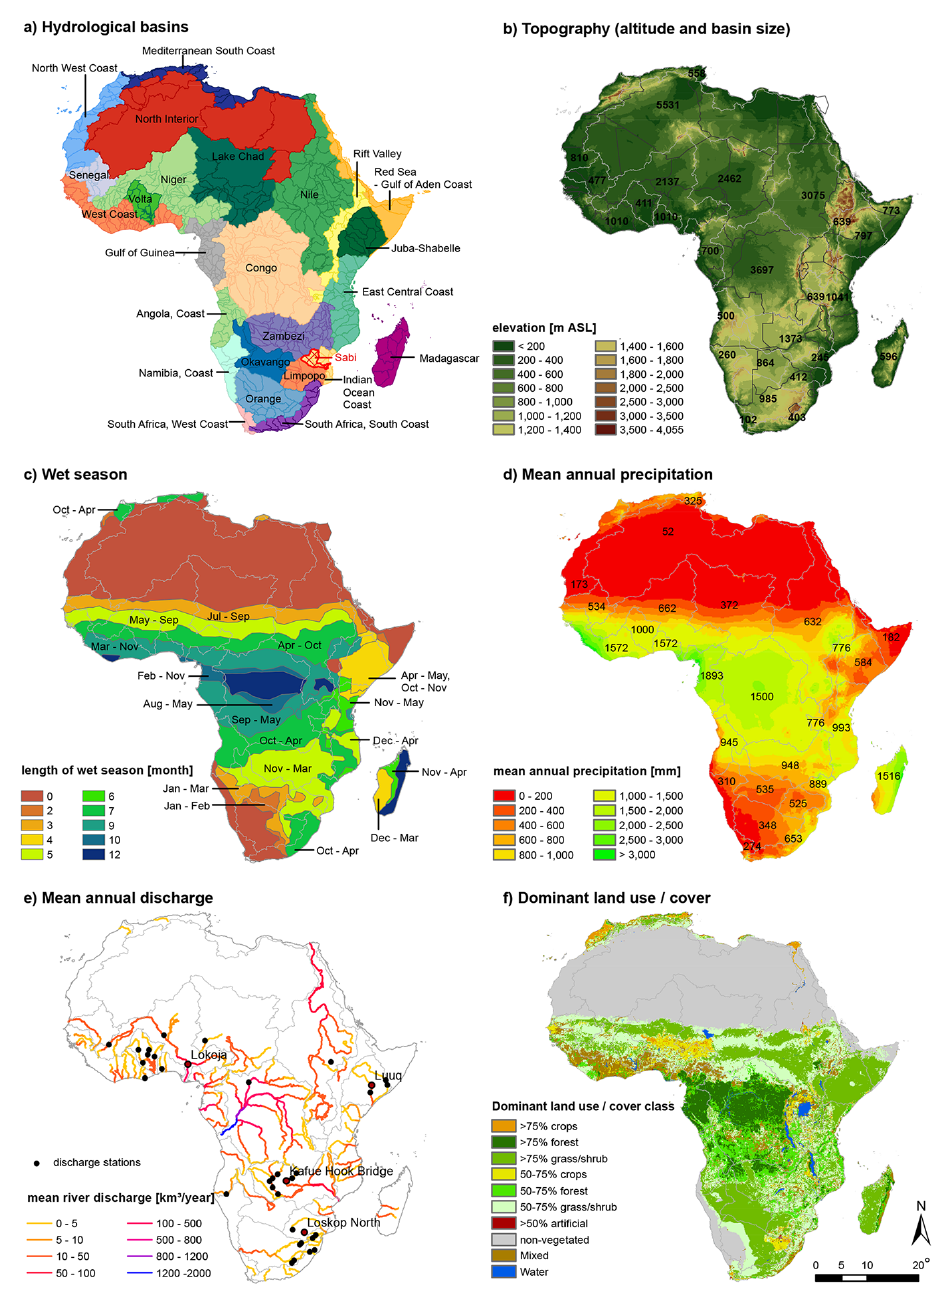
Figure 1. Overview of the study area; including (a) delineation of the hydrological basins (FAO), (b) altitude [ma.s.l.] and river basin size [1000km 2 ], (c) time period and length of the wet season (derived from CRU), (d) mean annual precipitation [mm] (CRU), (e) mean annual river discharge [km 3 ] (GRDC) and discharge station network and (f) dominant land use/cover